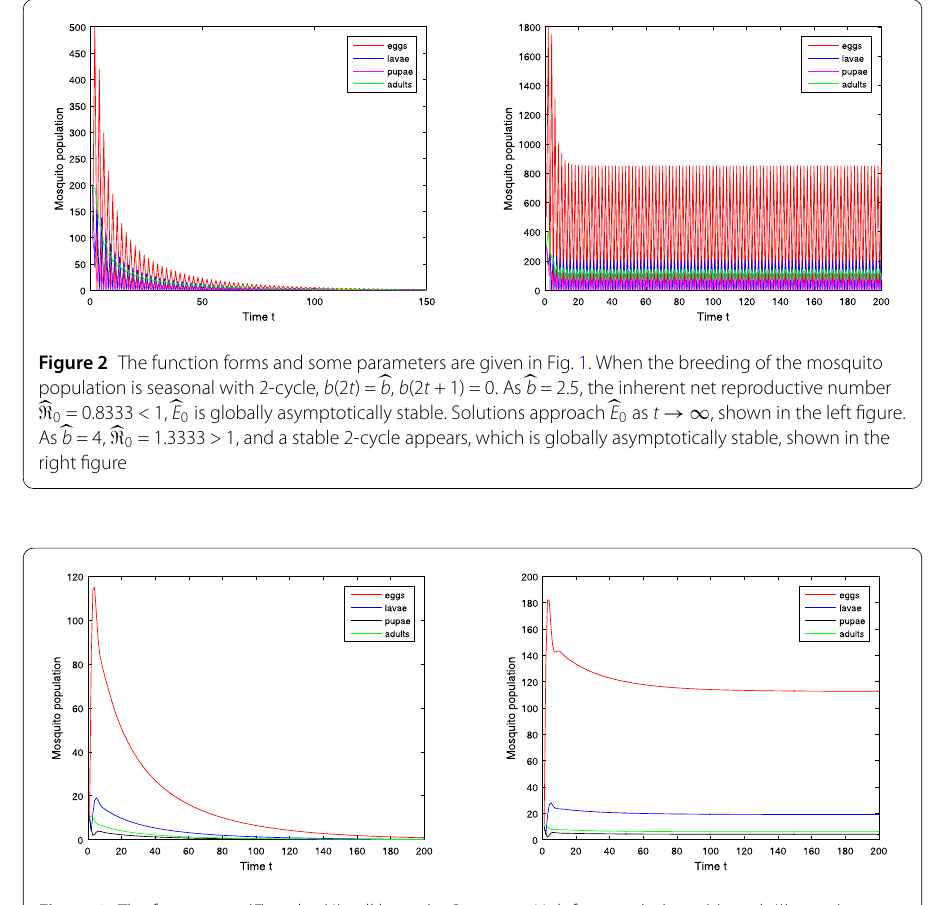
Figure 3 The functions s 1 ( E ) and s 4 ( A ) still have the Beverton–Holt form such that s i ( x ) = a i k i /( k i + a i x ), i = 1,4, but s 2 ( L ) has the Ricker-type nonlinearity such that s 2 ( L ) = a 2 e – L / k 2 and E (0) = L (0) = P (0) = A (0) = 10, other parameters are given in Fig. 1. As b = 8, the inherent net reproductive number (cid:2) 0 = 0.8329 < 1, trivial fixed point E 0 is globally asymptotically stable. Solutions approach E 0 as t → ∞ , shown in the left figure. As b = 13, (cid:2) 0 = 1.3534 > 1, E 0 becomes unstable and E 1 = (4.29,5.71,20,114.2), which is globally asymptotically stable, shown in the right figure